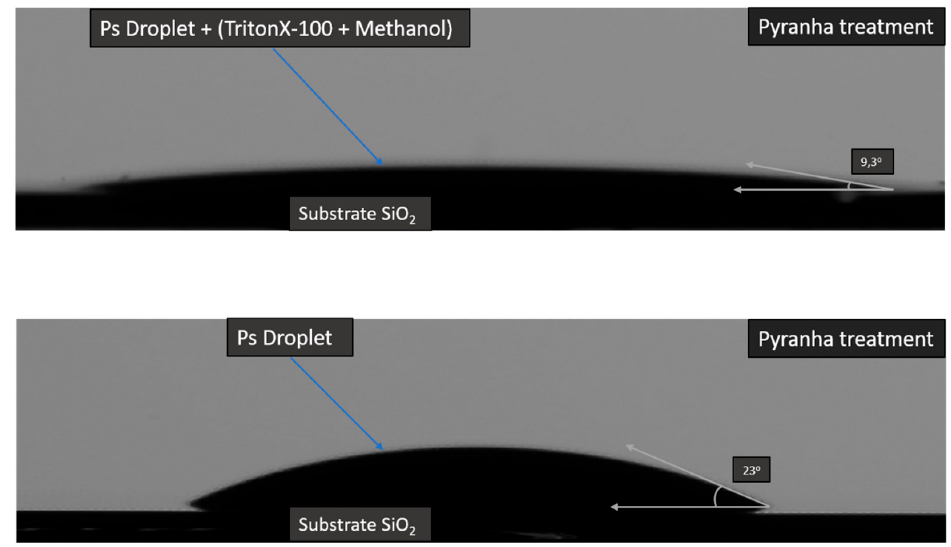
Figure 1. Contact angle measurements showing the improvement of wetting upon Triton X-100 surfactant addition in the aqueous suspension.